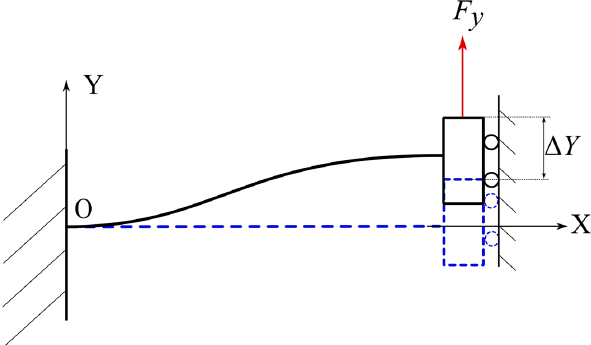
Figure 3. A beam flexure in compliant parallelogram mechanism.